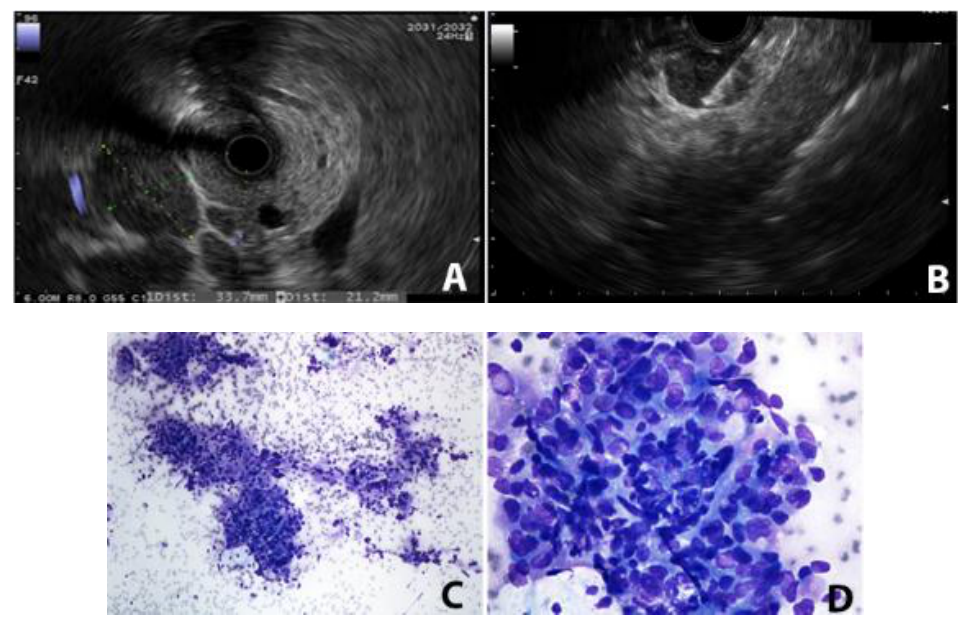
Figure 3. A, EUS showed an enlarged peripancreatic/periduodenal lymph node; B, EUS-FNA of enlarged celiac lymph node; Enlarged and hyperchromatic tumor cells (Diff Quickistain) displaying lack of polarity in low power (C), and high power